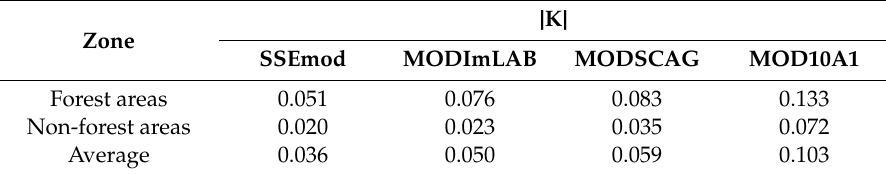
Table 4. The average of the absolute value of K in the forest and non-forest areas.